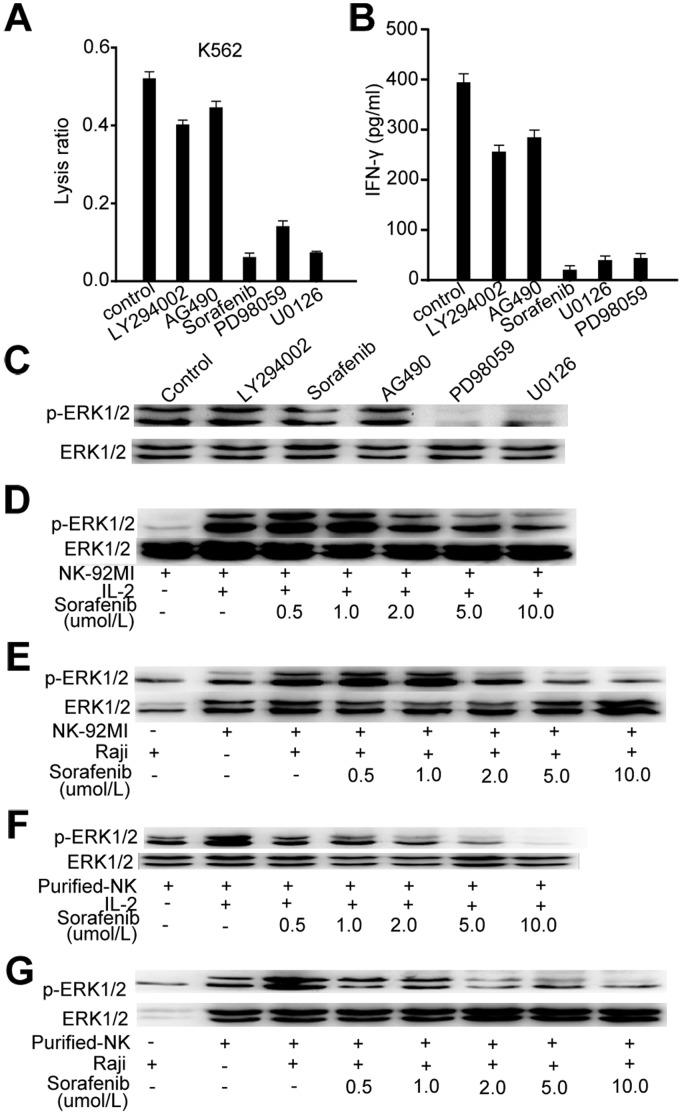
Sorafenib inhibited Raf/MEK/ERK signaling involved in NK activation.(A) NK cells were cultured with K562 cells (E:T = 30∶1) in the presence of sorafenib (10 µM) and the indicated specific inhibitors (10 µM). (B) NK cells were cultured with K562 tumor cells in the presence of sorafenib (10 µM) and the indicated specific inhibitors (10 µM). After 24 h, IFN-γ levels in cell culture supernatants were determined by ELISA. (C) Isolated human NK cells were treated with sorafenib and the indicated specific inhibitors for 30 min and exposed to IL-2 for 10 min. Subsequently, cell lysates were analyzed for phosphorylated ERK (pERK1/2) and whole (panERK) ERK1/2 protein. (D, E) NK92-MI cells were treated with different concentrations of sorafenib for 30 min and exposed to IL-2 for 10 min or fixed Raji cells for 15 min. Subsequently, cell lysates were analyzed as described in C. (F, G) Isolated human NK cells were treated with different concentrations of sorafenib for 30 min and exposed to IL-2 for 10 min or fixed Raji cells for 15 min.